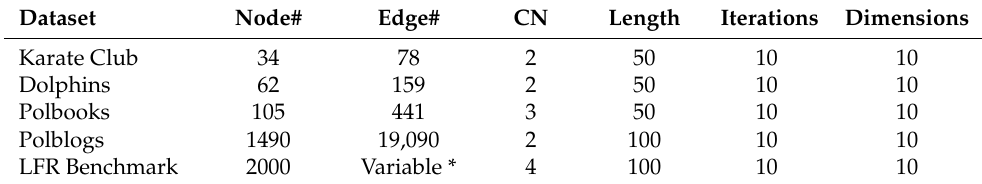
Table 1. Main properties of datasets and experimental